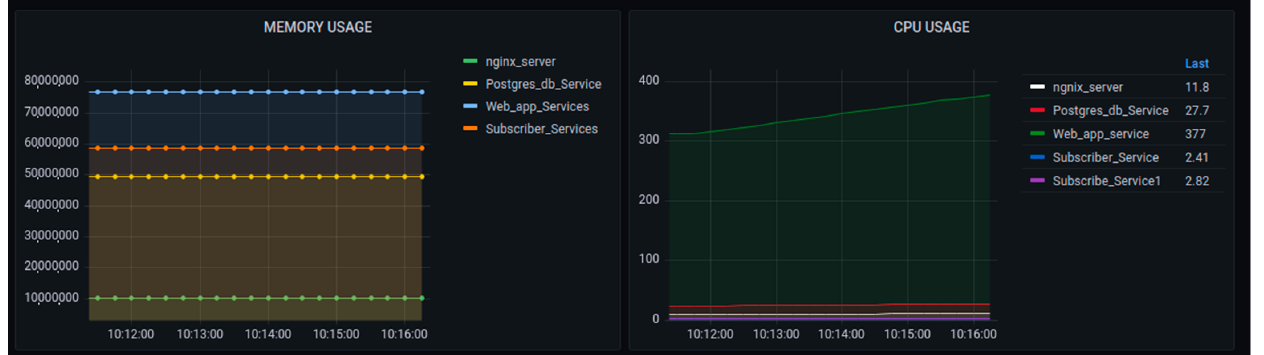
Figure 21. Performance of the platform after scaling up with 1,000,000 requests: memory and CPU usage.